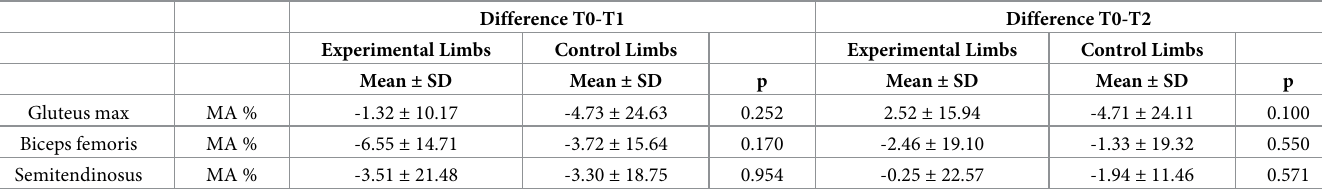
Table 5. Inter-group electrical activity